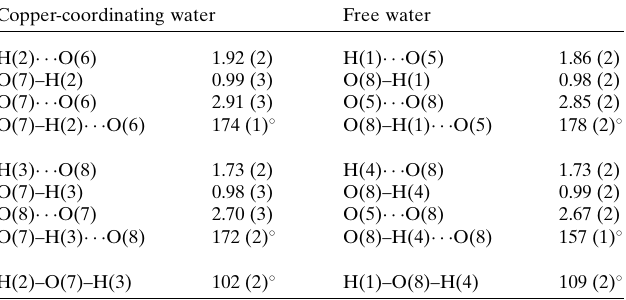
Table 2 Interatomic distances (A˚ ) and bond angles ( (cid:4) ) for water molecules in metatorbernite.